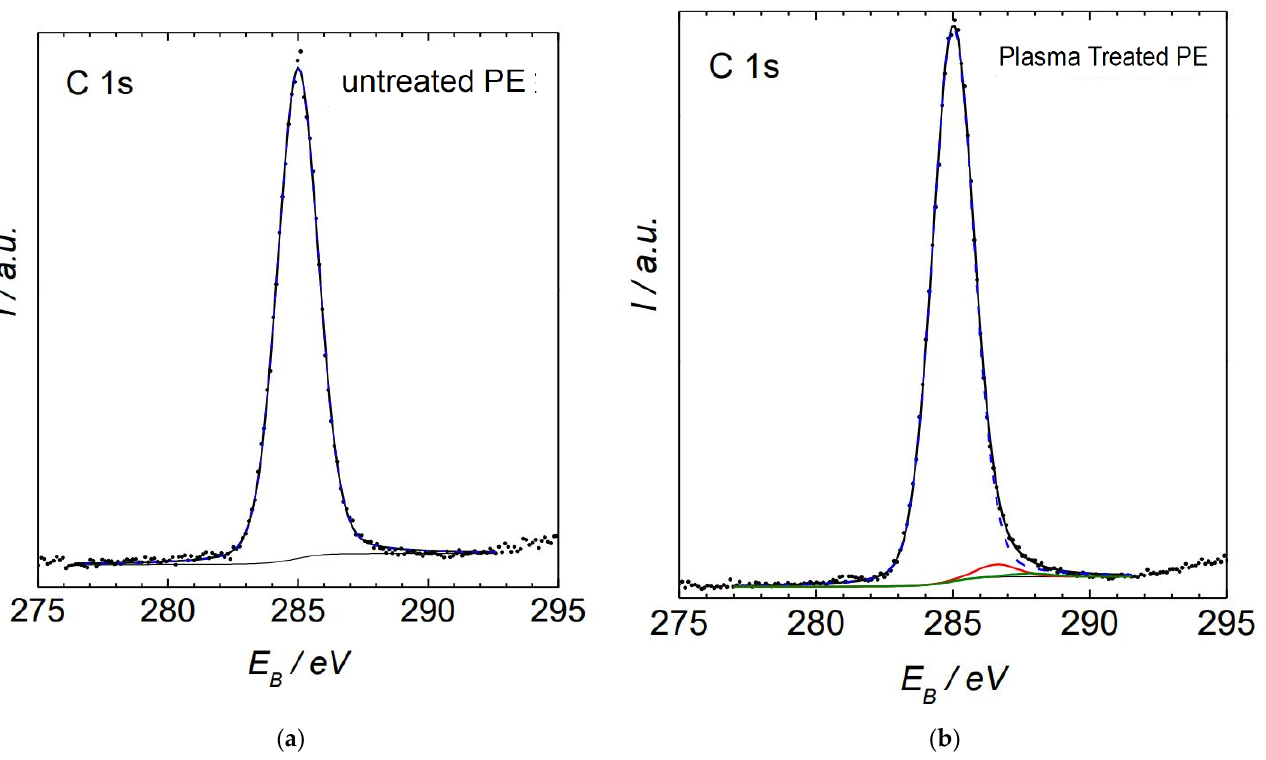
Figure 18. XPS results of PE powder: ( a ) untreated PE [27], ( b ) plasma-treated PE. Black line with O-C=O bond, blue line with C-C bond, green and red line with C=O and C-O bonds, respectively.